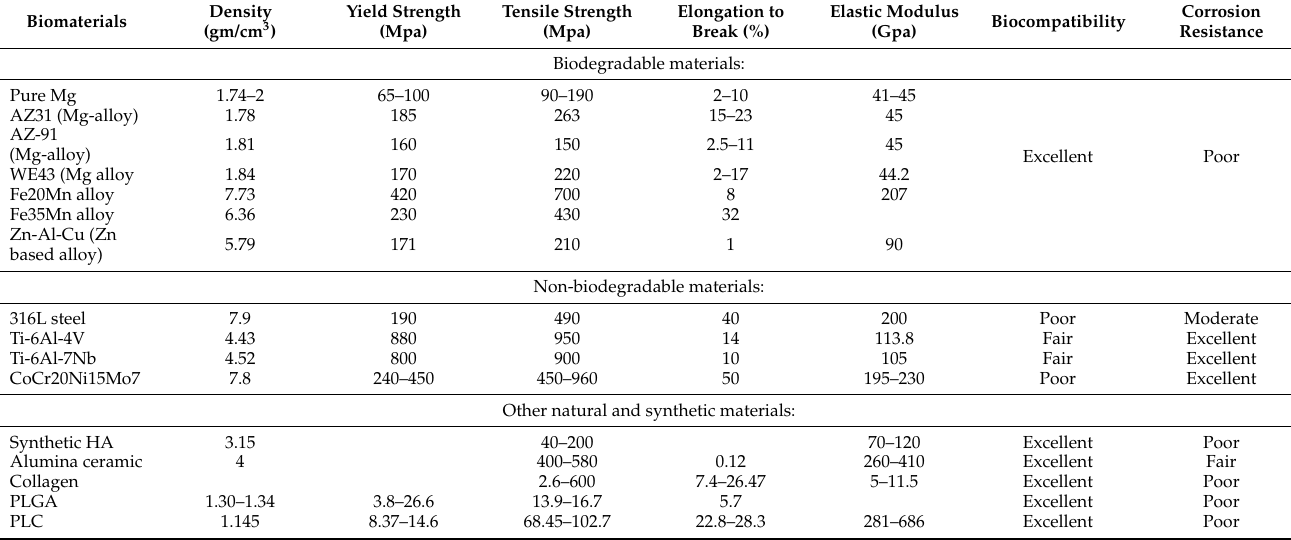
Table 1. Mechanical characteristics, biocompatibility, and corrosion resistance of commonly used biomaterials [11]. Biomaterials Density (gm/cm 3